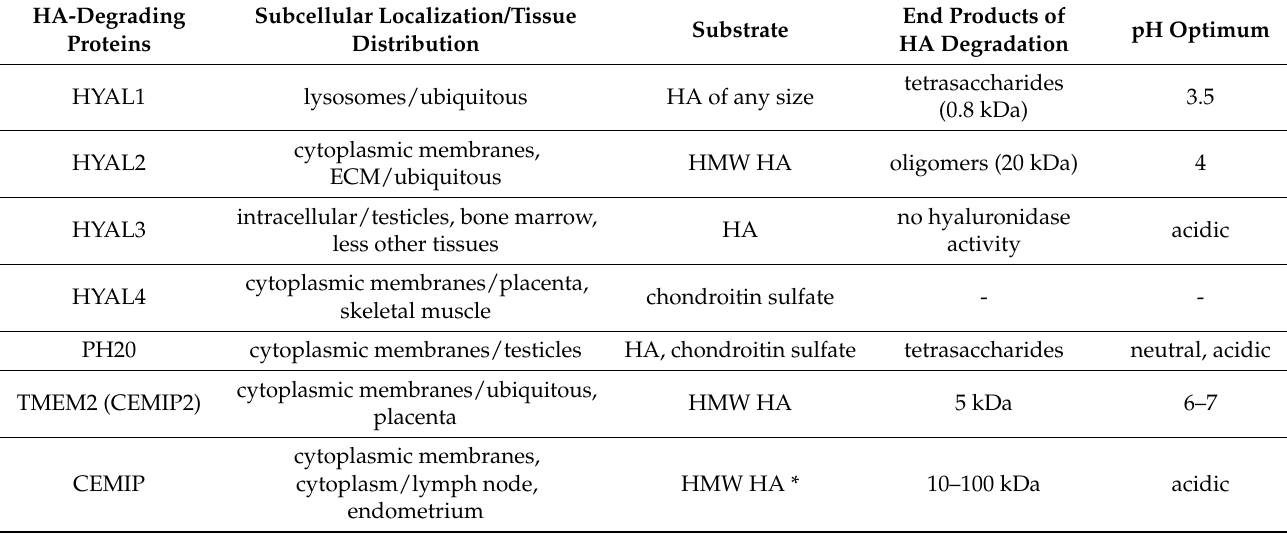
Table 1. Overview of HA-degrading